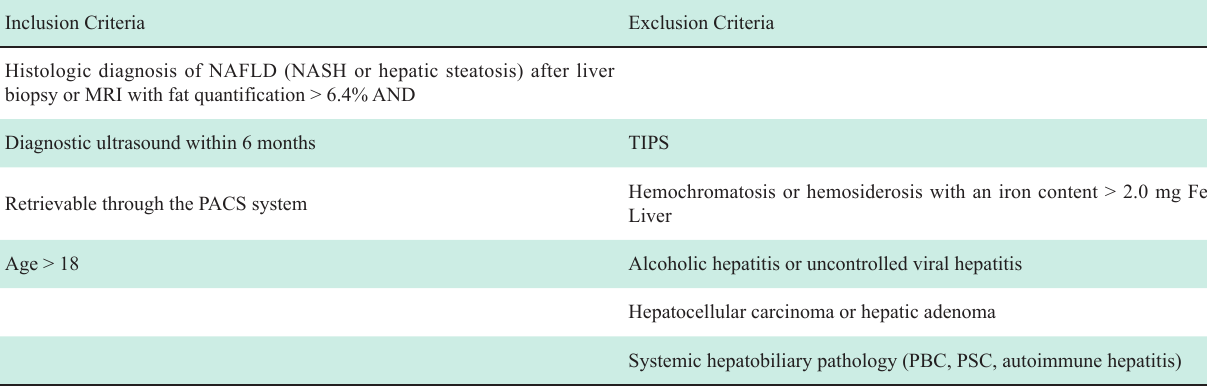
Table 1 Inclusion and exclusion criteria for patients within the “Fatty Liver” label Inclusion